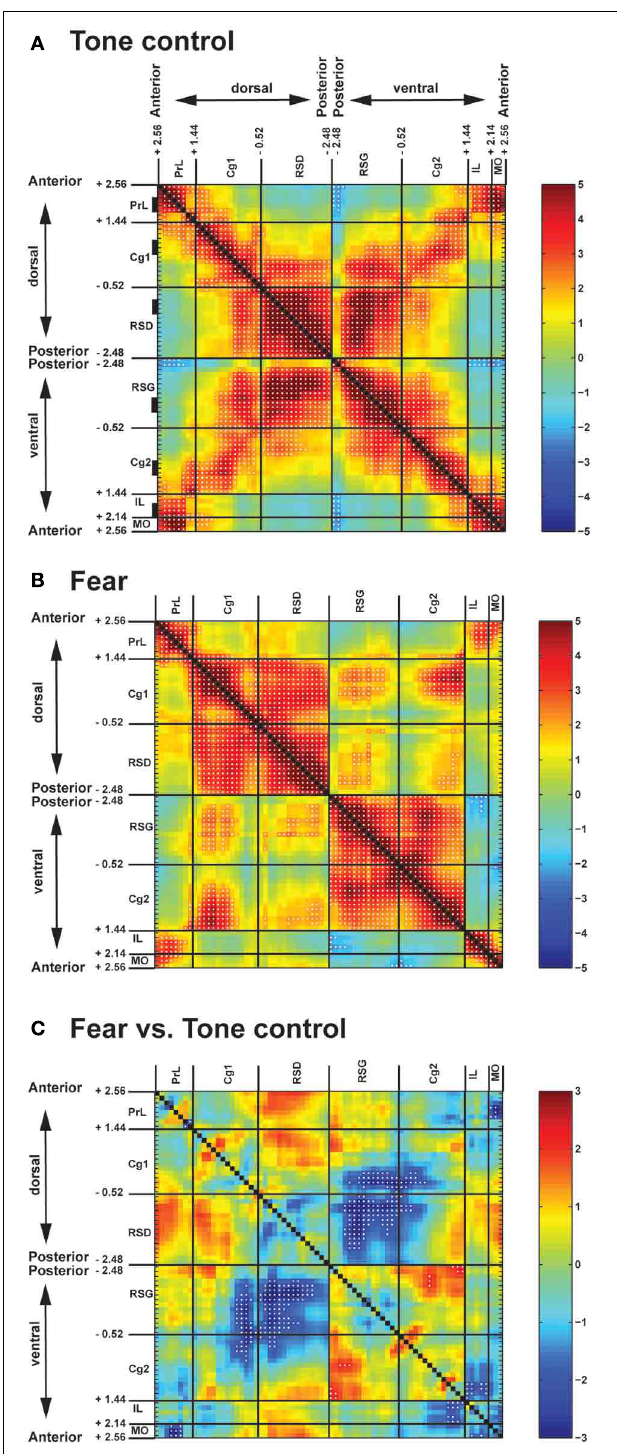
FIGURE 2 | Pairwise inter-regional correlation matrices showing functional connectivity among cortical midline structures of fear-conditioned and control mice. (A) Control mice exposed to a neutral tone. (B) Fear-conditioned mice during auditory-cued fear recall. Z -scores of Pearson’s correlation coefficients are color-coded. Each matrix is symmetric